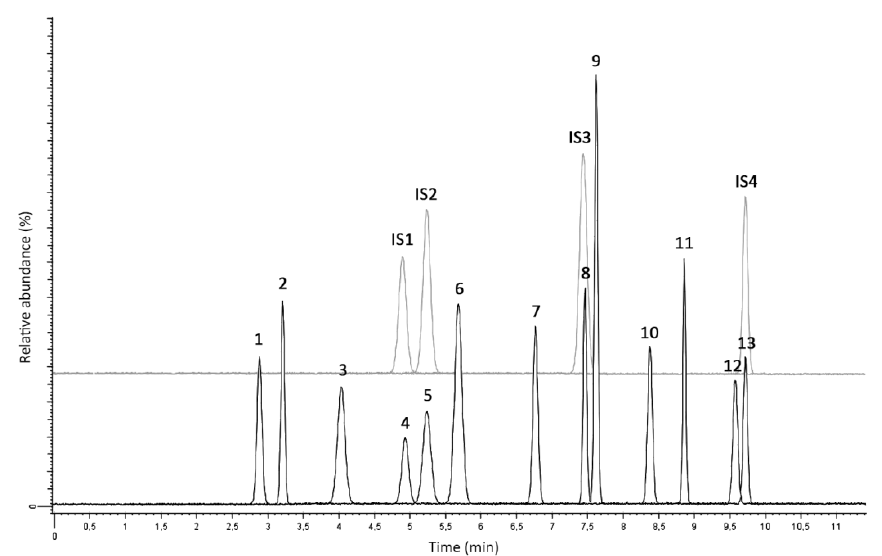
Figure 1. Liquid chromatography–tandem mass spectrometry (LC-MS/MS) chromatogram of a blank VAMS sample spiked with the analytes and ISs. 1: fluoxymesterone, 2: 1-androstenedione, 3: